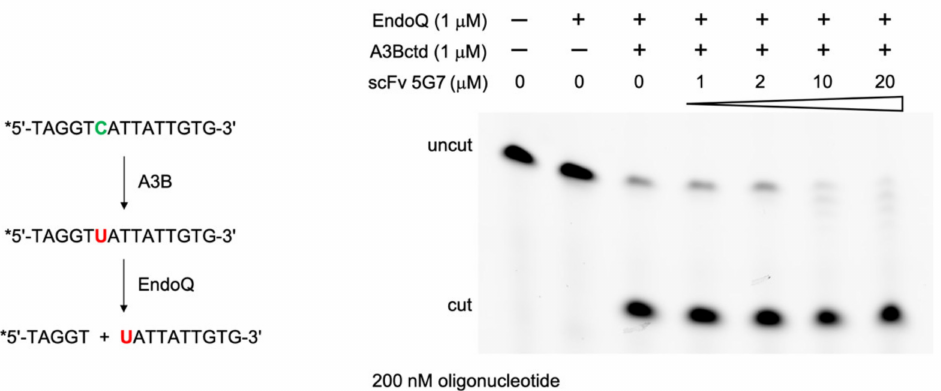
Figure 2. scFv 5G7 does not inhibit A3B DNA deaminase activity. Schematic diagram (left) shows the principle of the DNA cytosine deaminase assay mediated by EndoQ [20]. Fluorescent label on the 5’ end of the oligo DNA substrate is denoted by an asterisk (*). The assay result (gel image on the right) shows that the addition of scFv 5G7 up to 20 µ M had no inhibitory effect on the A3B activity. At higher concentrations of scFv 5G7, the residual uncut DNA band shows a ladder pattern, which is probably due to a contaminating exonuclease activity in the scFv 5G7 preparation.